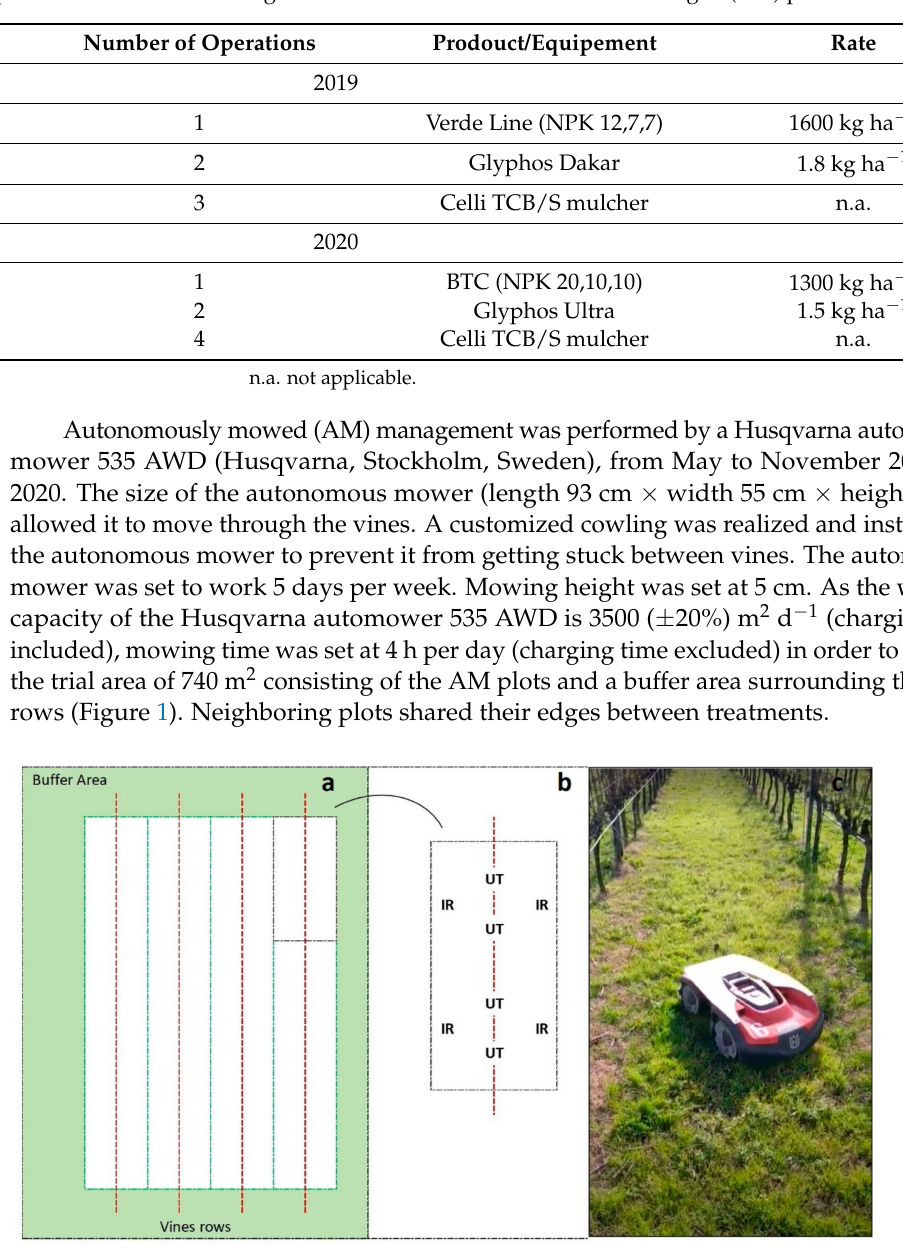
Table 1. List of operations carried out during 2019 and 2020 for the conventional managed (CM) plots.